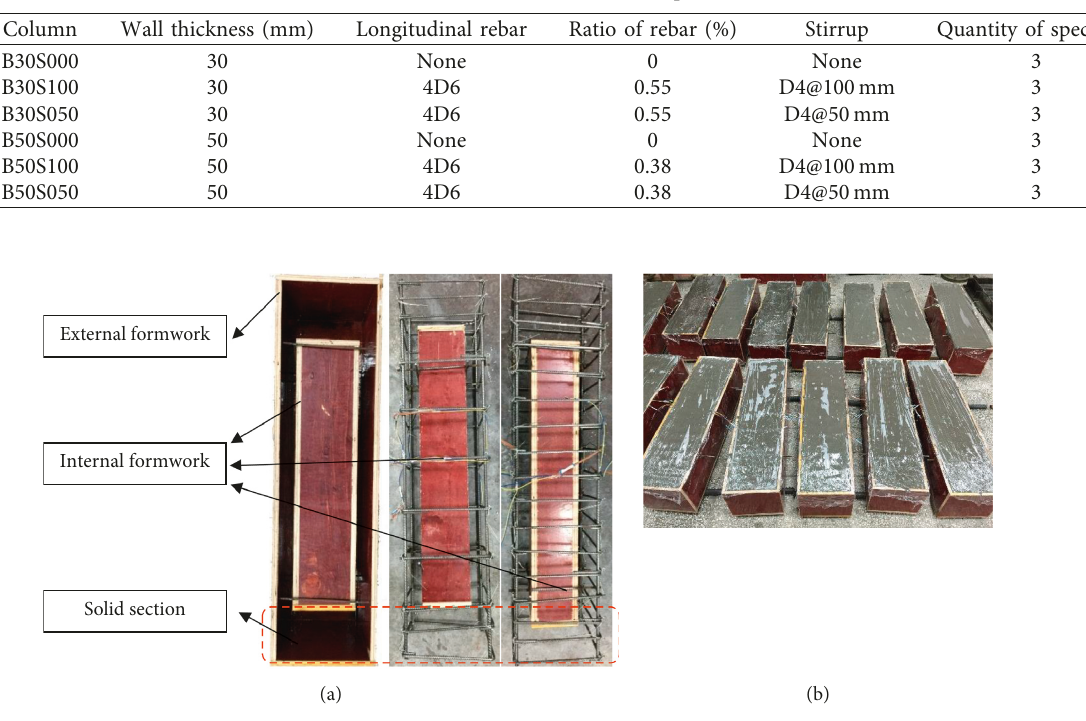
Figure 1: Specimen details. (a) Formwork creation and installation. (b) UHPFRC casting.